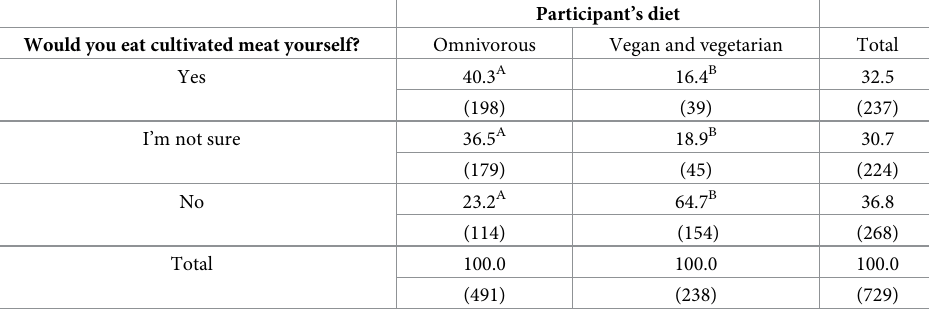
Table 2. Attitudes to consuming cultivated meat, by participants’